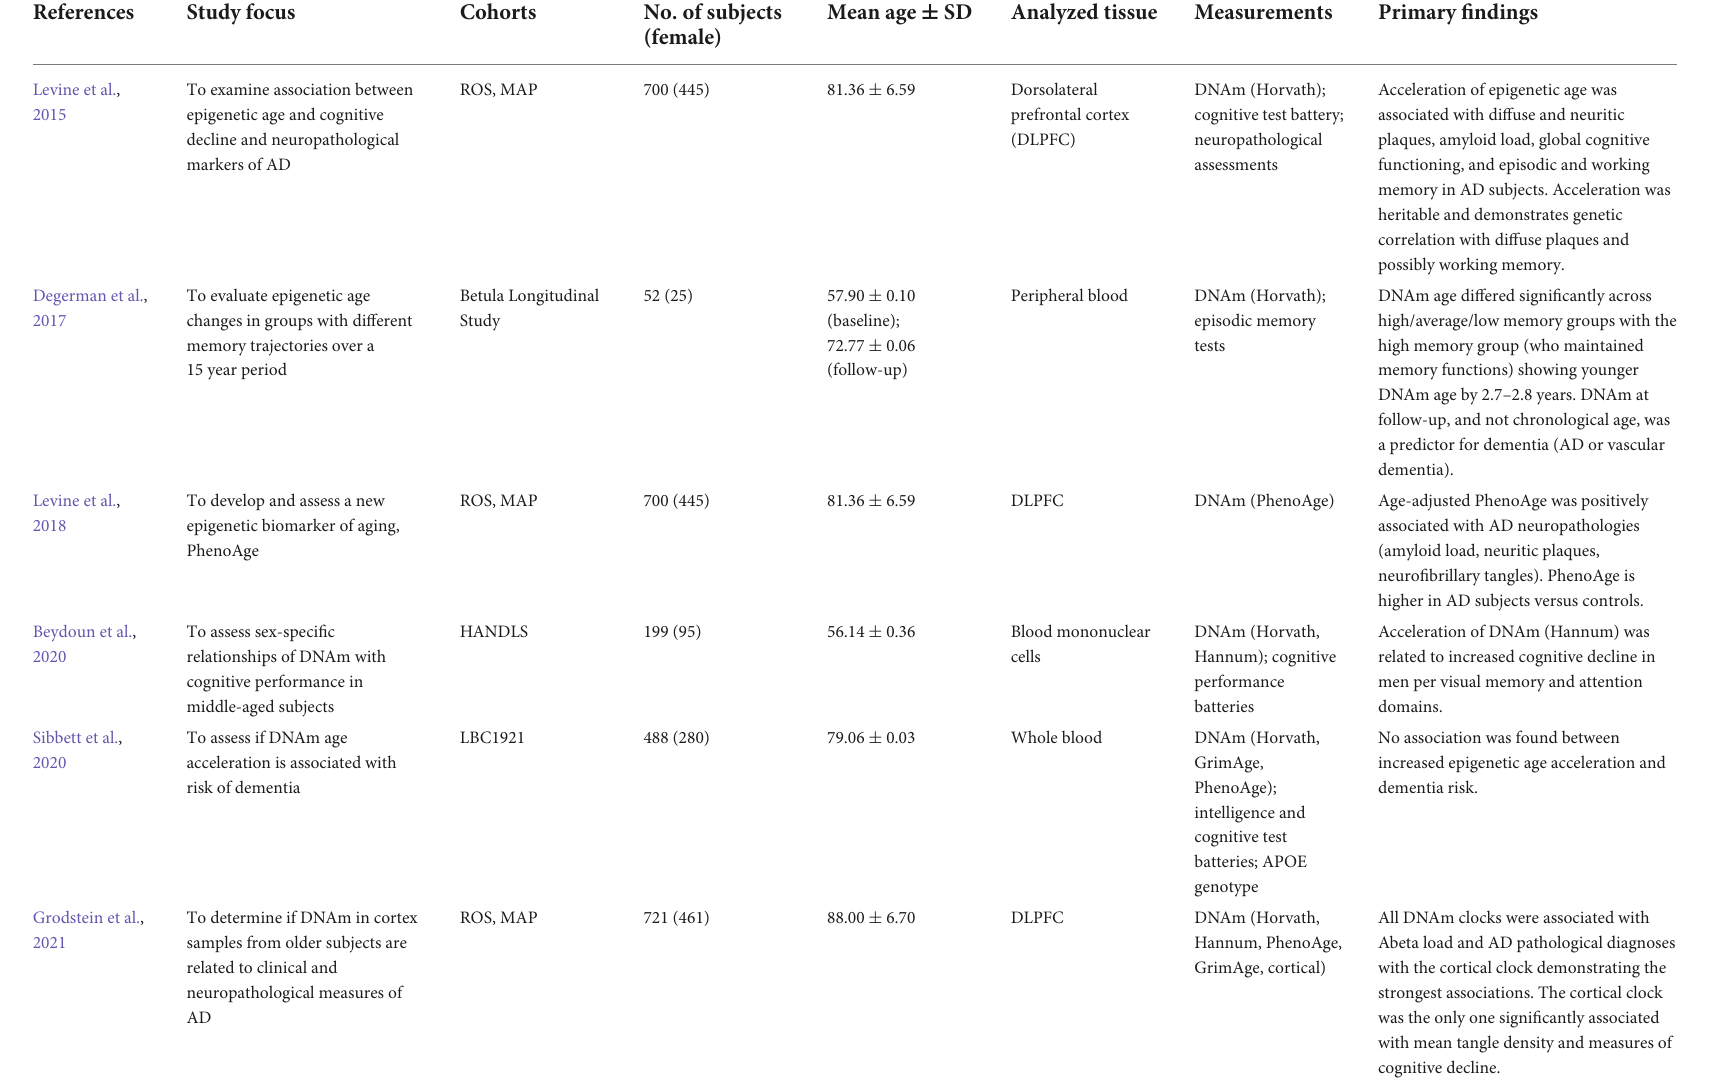
TABLE 2 Human epigenetic age studies on cognitive functions, dementia, mild cognitive impairment (MCI), and/or Alzheimer’s disease